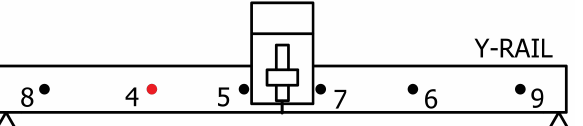
Figure 7. Measurement points on Y-rail, with the red one corresponding to excitation.